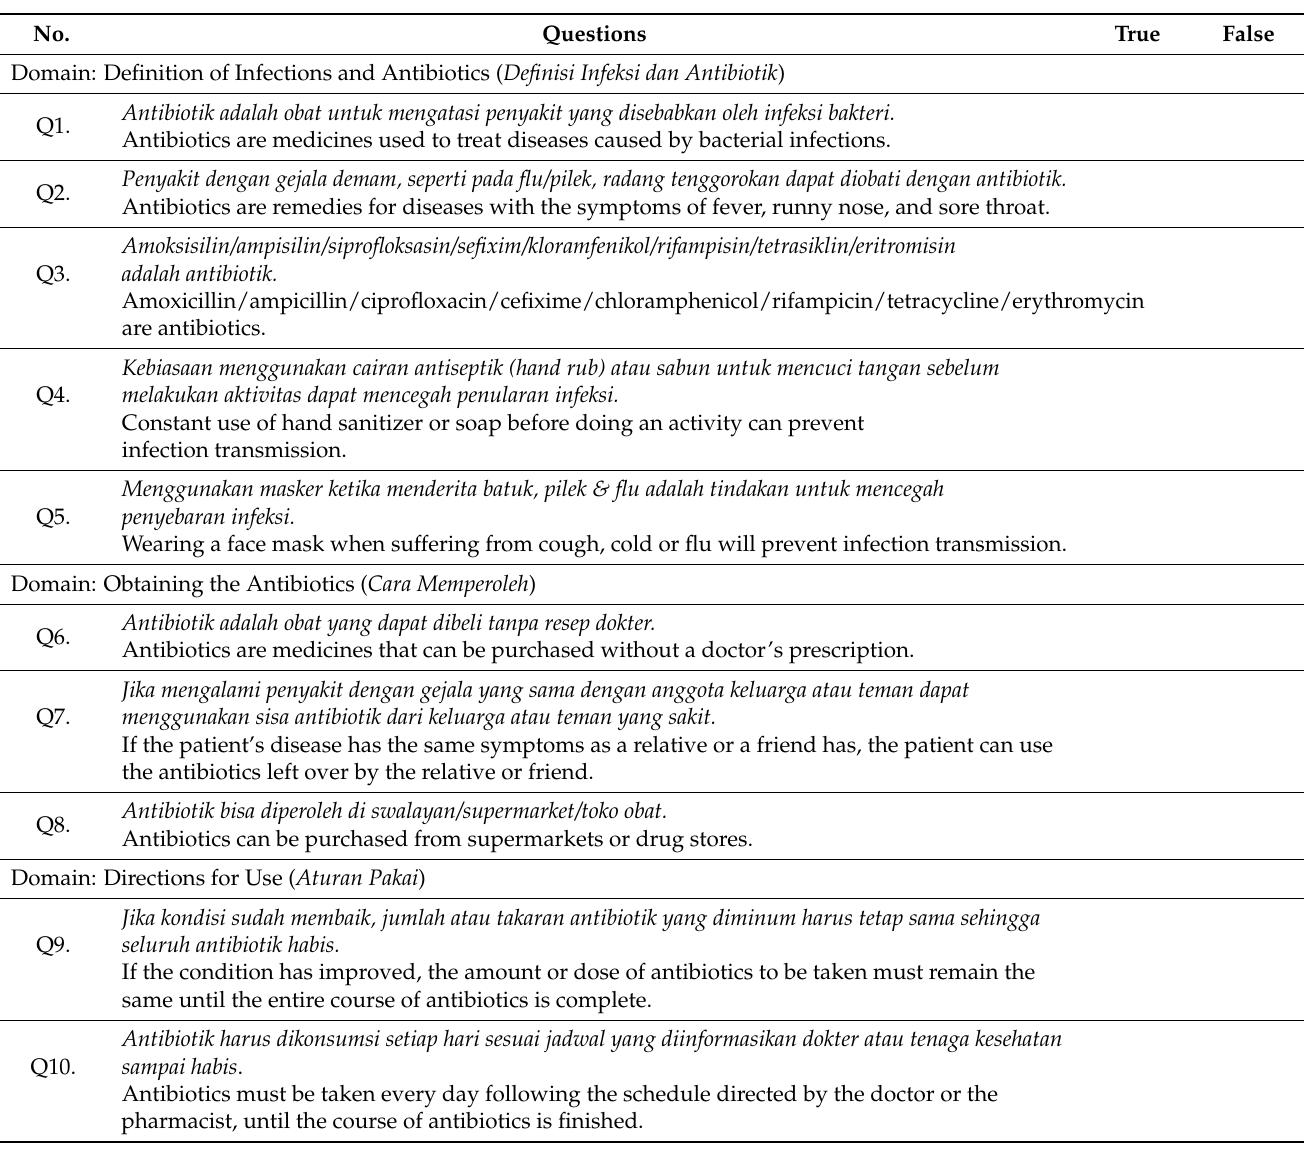
Table A1. The patient’s knowledge questionnaire used before and after video intervention (Indonesian language